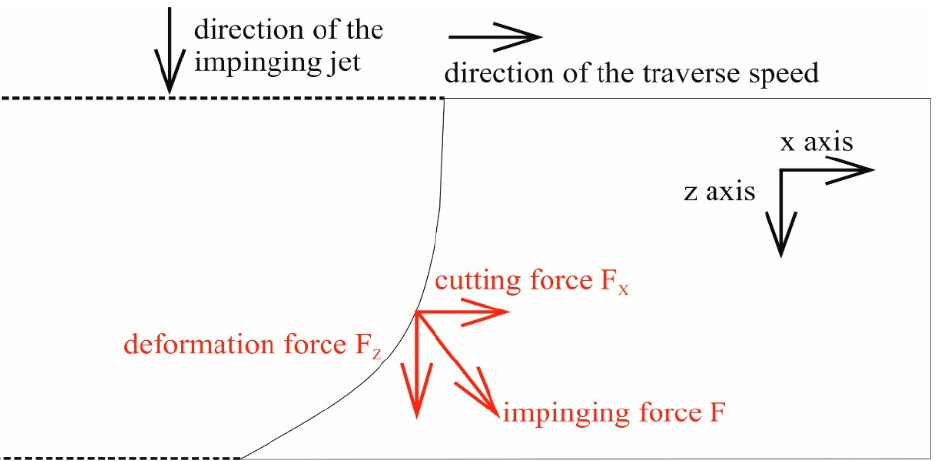
Figure 1. Scheme of the force decomposition in a certain point on the heading line characterizing the trajectory of the penetrating jet (the perpendicular direction to the traverse speed and gravity is not analysed in this study, so the impinging force is reduced into two dimensions).